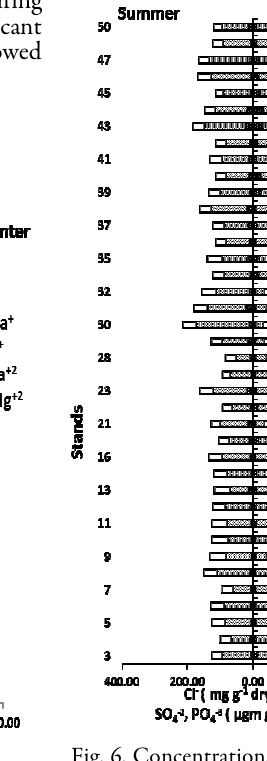
Fig. 5. Concentrations of major soluble cations (Na + , K + , Ca +2 , and Mg +2 ) expressed in mg g -1 d.wt. in Zilla spinosa and Leptadenia pyrotechnica plants in summer and winter seasons